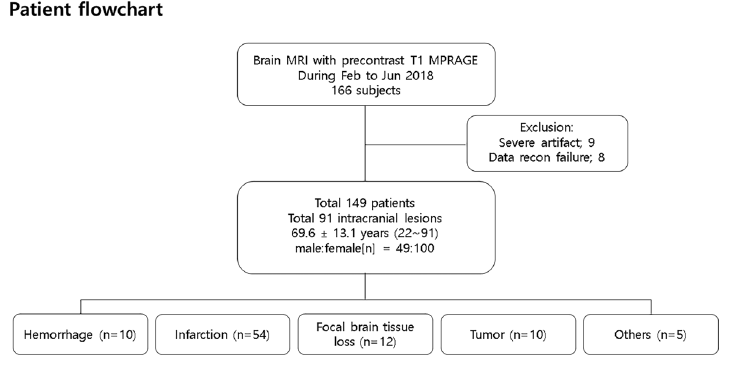
Figure 1. Patient flow